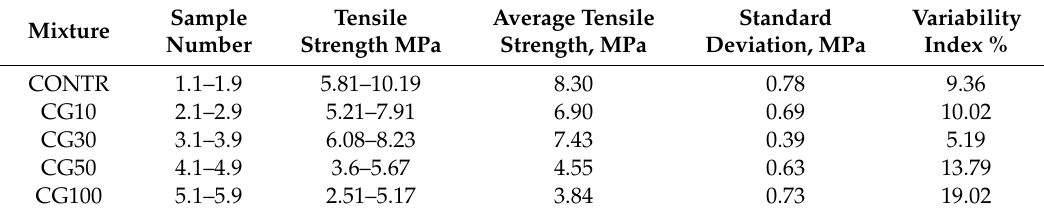
Table 11. Results of tensile (flexular) testing of concrete